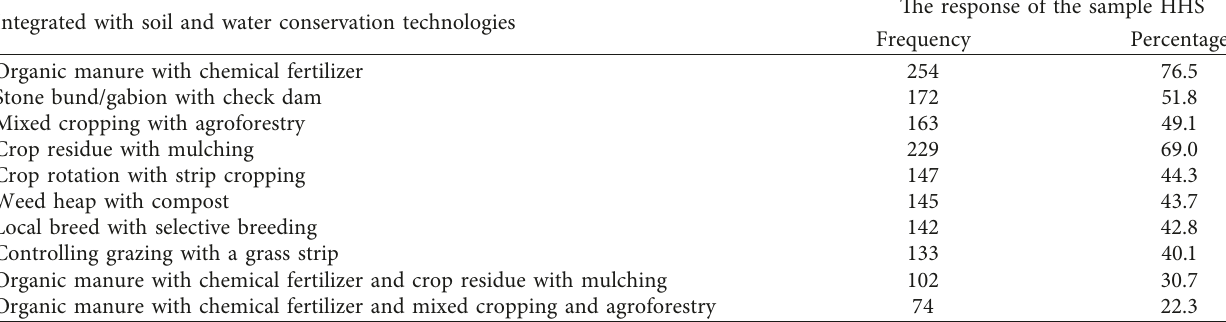
Table 7: How traditional and modern soil and water conservation technologies have been